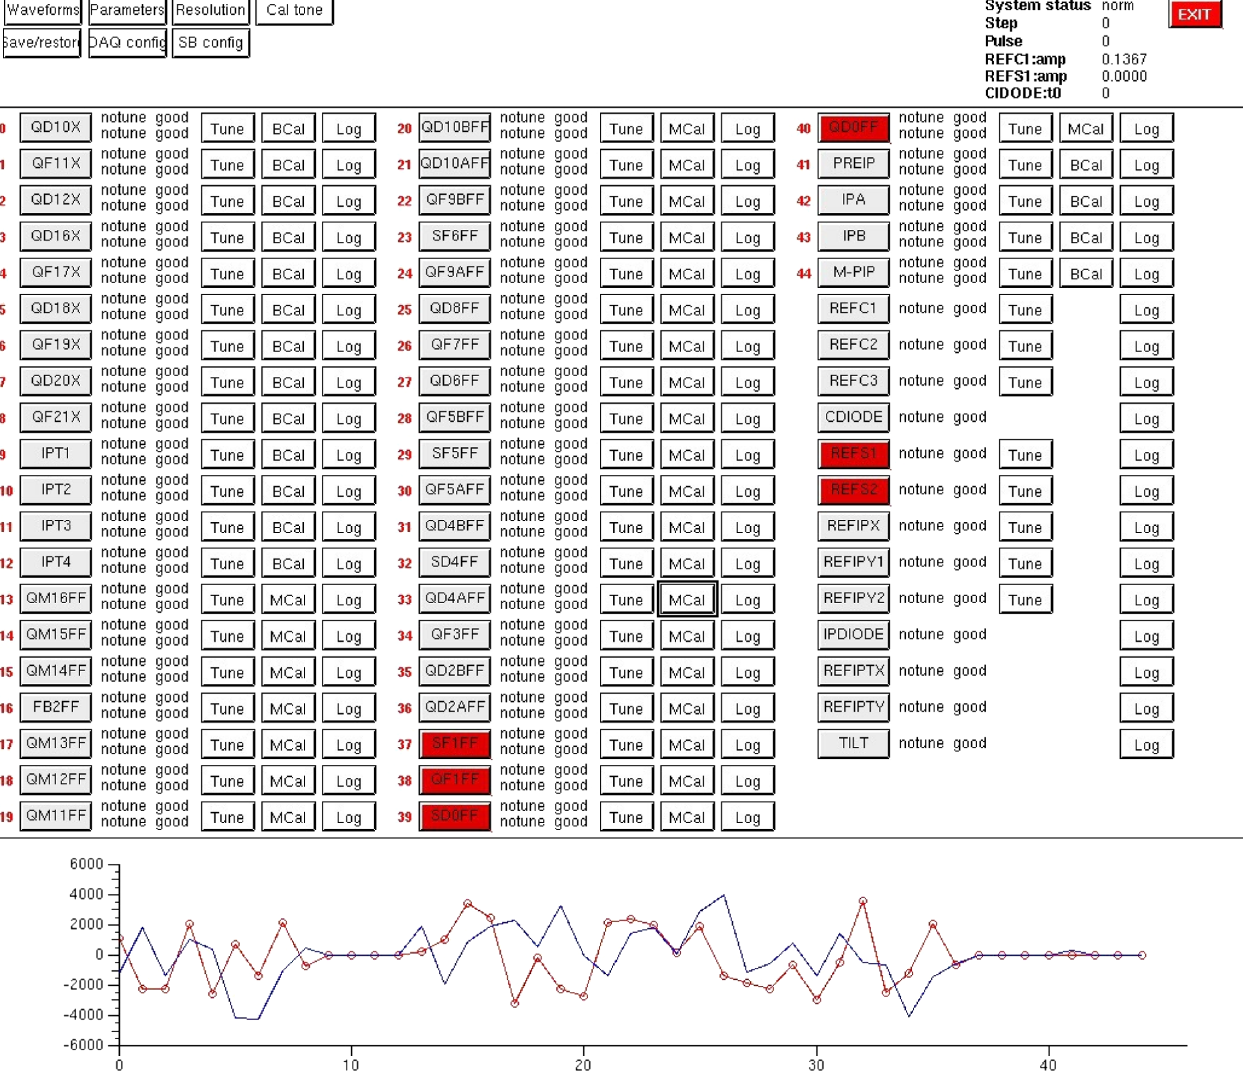
FIG. 14. A screen shot of the main EDM CBPM panel. The window shows all the CBPMs in beam-line order, with status indicators indicating the calibration status (notune, uncalibrated, normal), digitizer signal status (normal or staturated), and controls to set the digital processing parameters (Tune), perform calibration (BCal or MCal), and save CBPM (Log)